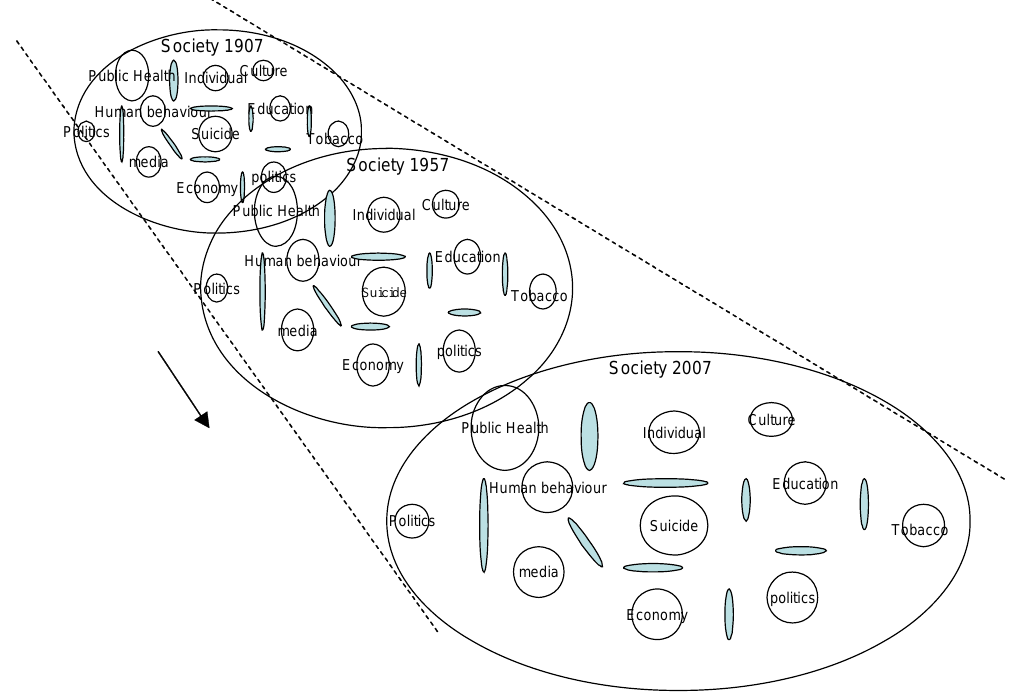
FIGURE 11 . An example of a conceptual holistic model of